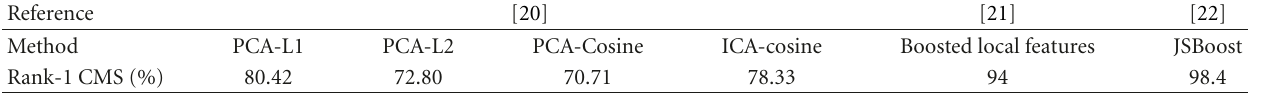
Table 8: List of the referenced results based on di ff erent releases.